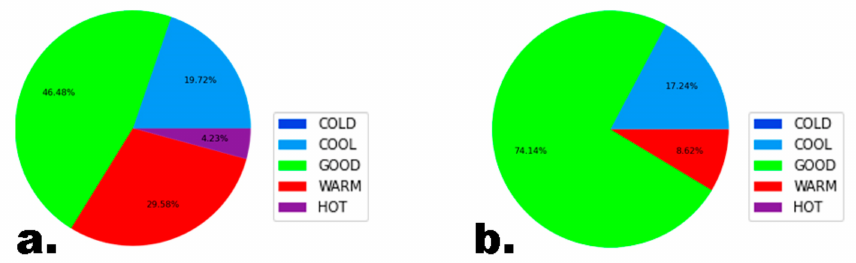
Figure 17. Feedback distribution for the two platforms: ( a ) MP-A00003 and ( b ) MP-A00013.